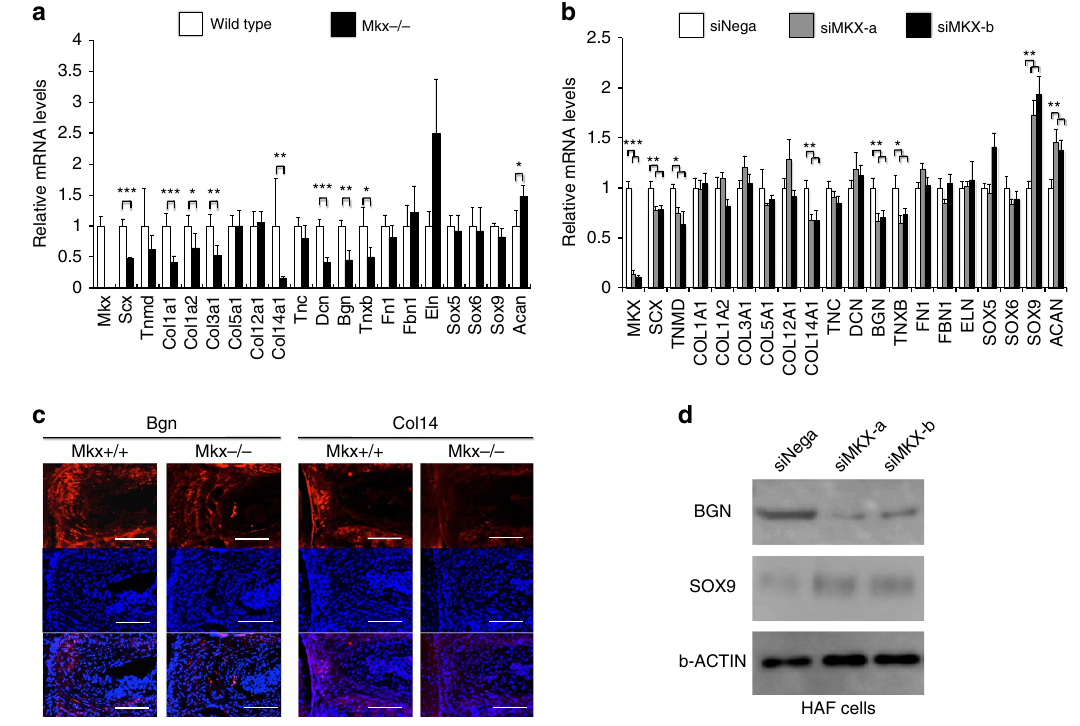
Figure 3 | Molecular analyses of the annulus fibrosus (AF) cells. ( a ) Quantitative real-time reverse transcription PCR (qRT–PCR) analyses of the expression of ligament-related genes in Mkx þ / þ and Mkx (cid:2) / (cid:2) mice. The mRNA levels of ligament markers in Mkx þ / þ mice were normalized to 1. Error bars represent s.e.m. * P o 0.05, ** P o 0.01, *** P o 0.001. Statistical differences were assessed with Student’s t -test. ( b ) qRT–PCR analyses of ligament- and cartilage-related gene expression in human AF cells transfected with a small interfering RNA for MKX (si MKX -a and si MKX -b) or the negative control (siNega). The mRNA levels of ligament markers in human AF (HAF) primary cultured cells transfected with siNega were normalized to 1. Error bars represent s.e.m. * P o 0.05, ** P o 0.01, *** P o 0.001. Statistical differences were assessed with Student’s t -test. ( c ) Immunohistochemistry (IHC) of the intervertebral disc (IVD) of 10-week-old Mkx þ / þ and Mkx (cid:2) / (cid:2) mice. IHC shows little decreased Bgn and Col14 protein expression in Mkx (cid:2) / (cid:2) mice compared with Mkx þ / þ mice. Red: Bgn and Col14. Blue: DAPI. Scale bars, 100 m m. ( d ) Western blot analyses of human AF cells. Western blotting showed decreased BGN and increased SOX9 protein expression following siMKX induction of HAF